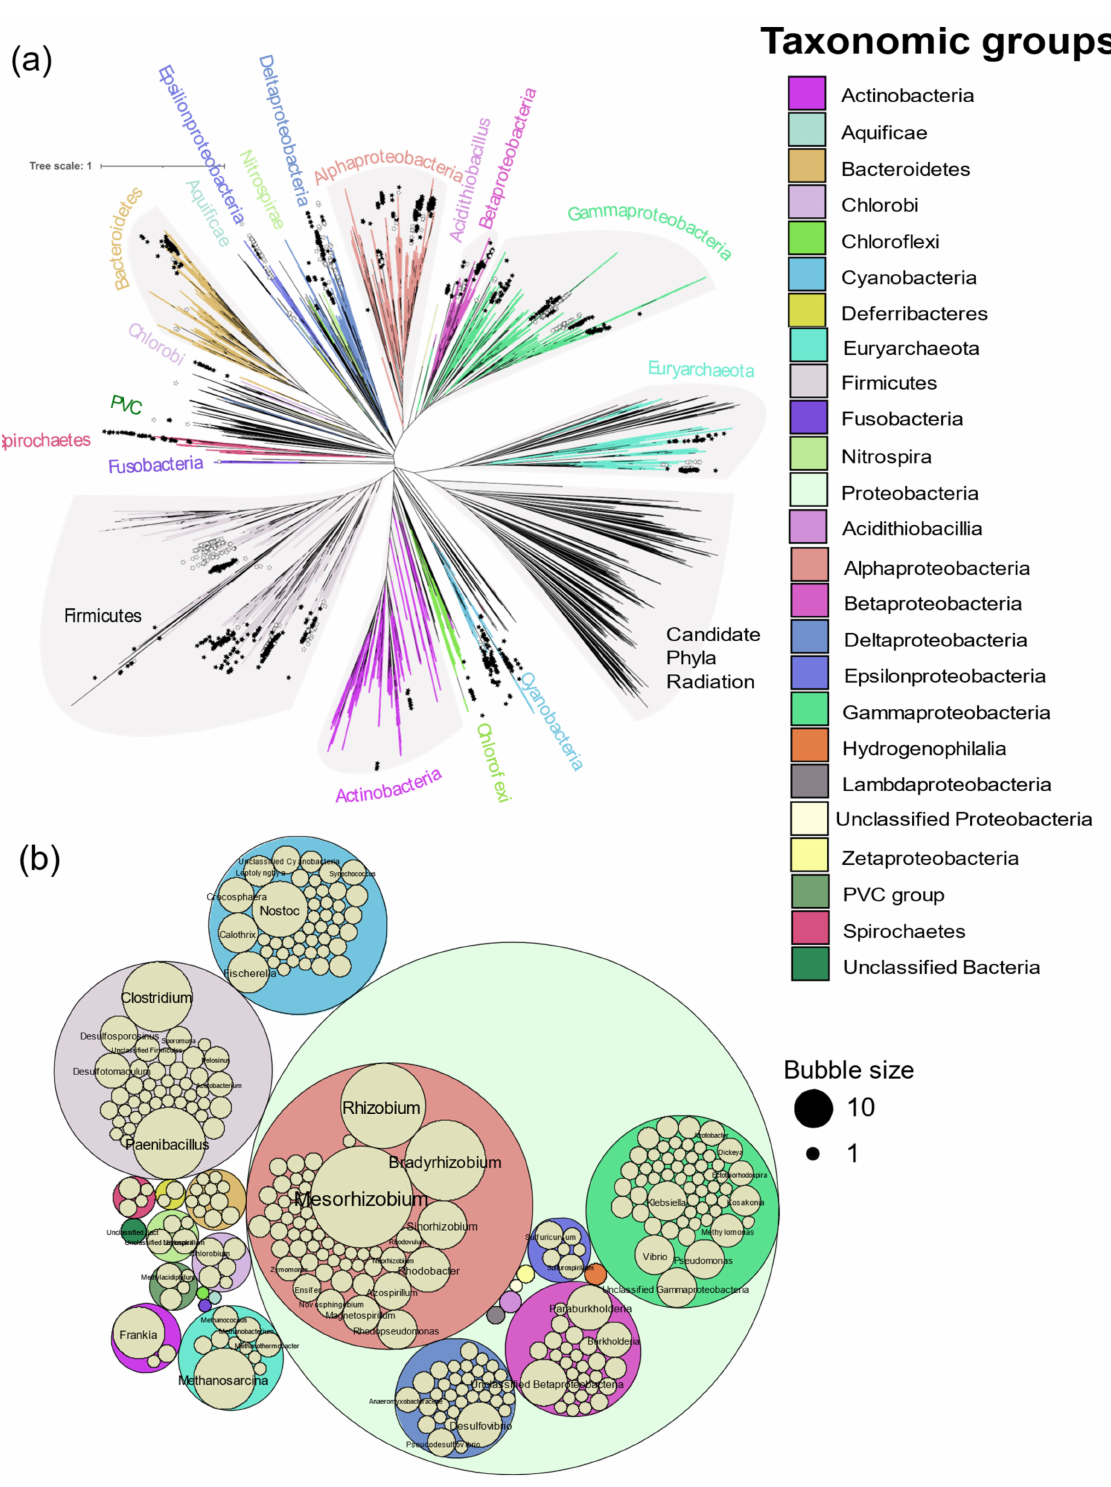
Figure 3. Distribution of diazotrophs by genus. ( a ) Distribution of diazotrophs in the tree of life proposed by Zhu et al. [23]. Nexus tree file for all prokaryotes was visualized in iTOL and leaves were annotated by genus according to the evidence of diazotrophy observed in this study. Solid and open symbols represent genera with and without biochemical evidence respectively. Genera without a star had neither genomic nor biochemical evidence of diazotrophy. ( b ) Distribution of the diazotrophic genera by the number of species observed in each genus. Bubble size corresponds to the number of assemblies of that genus and